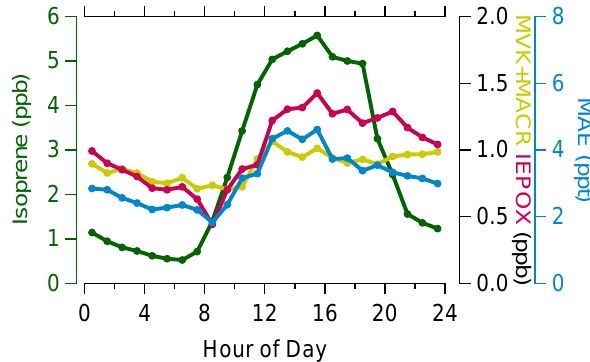
Figure 4. Diurnal variation of isoprene (left ordinate) as well as isoprene gaseous 3 photooxidation products (right ordinates), i.e., MVK + MACR, IEPOX and MAE, measured at LRK site. It should be noted that IEPOX signal includes interference of ISOPOOH at unknown ratio; thus its mixing ratio represents an upper